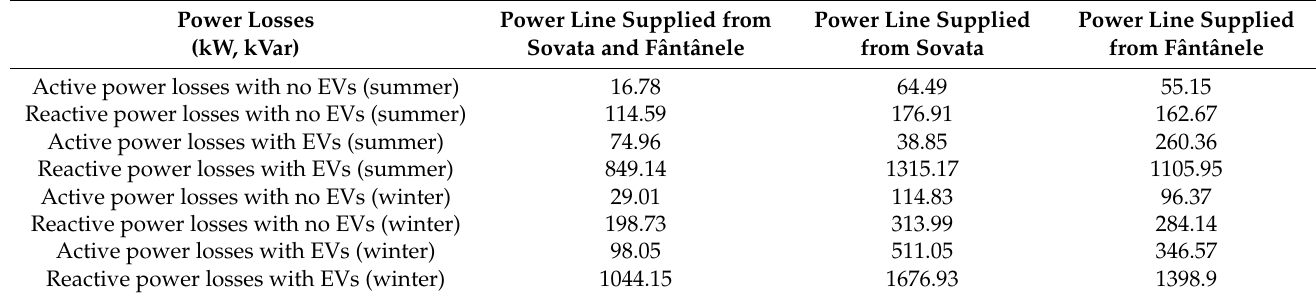
Table 12. Power losses at 5:00 (scenario 2).